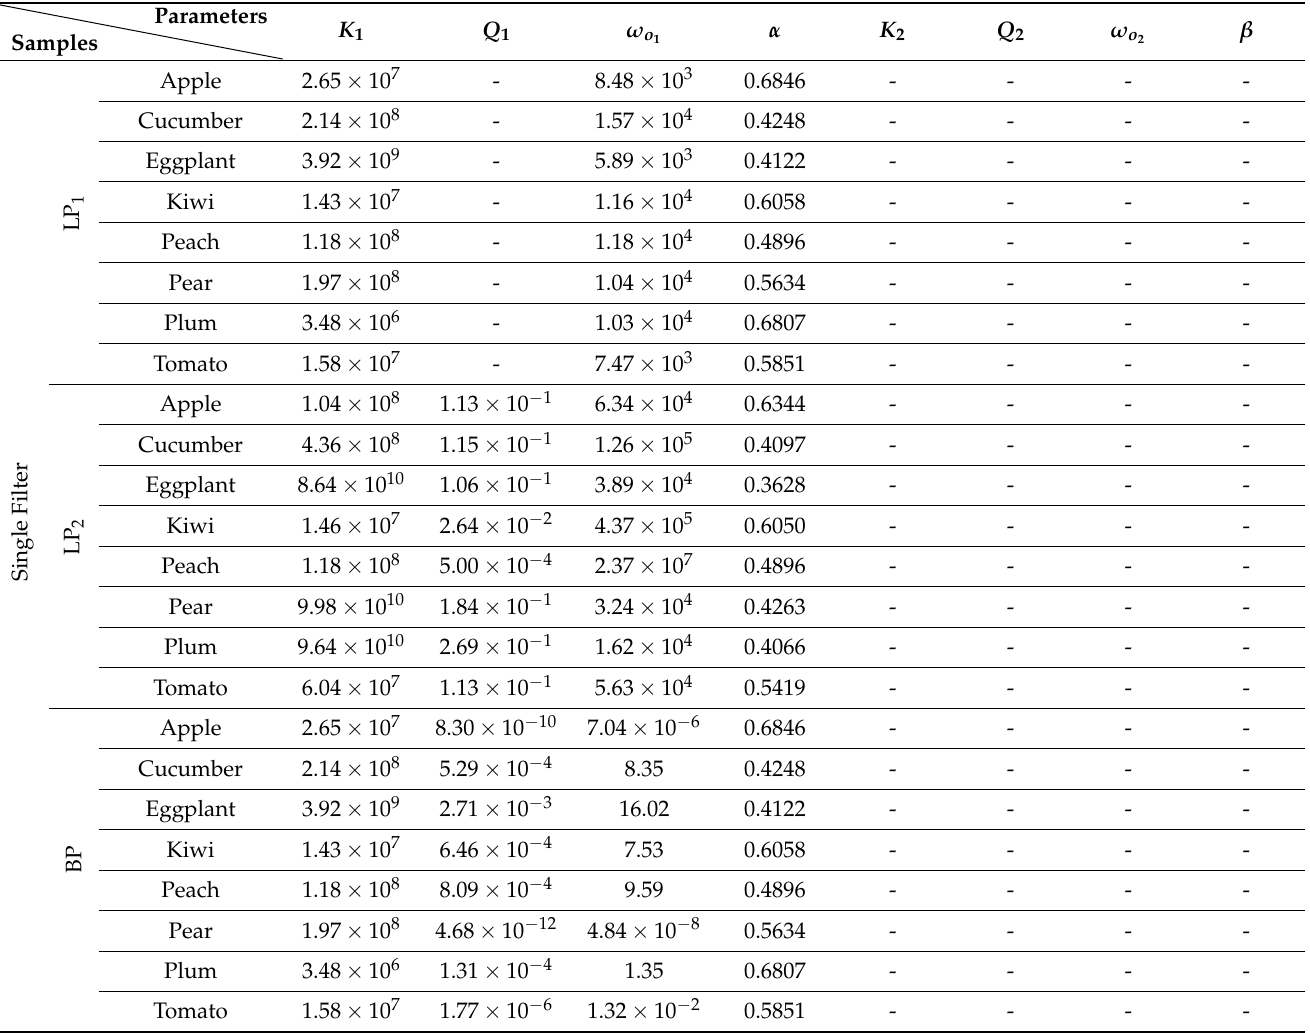
Table 1. Extracted parameters from the measured fruit samples using the WCA optimization